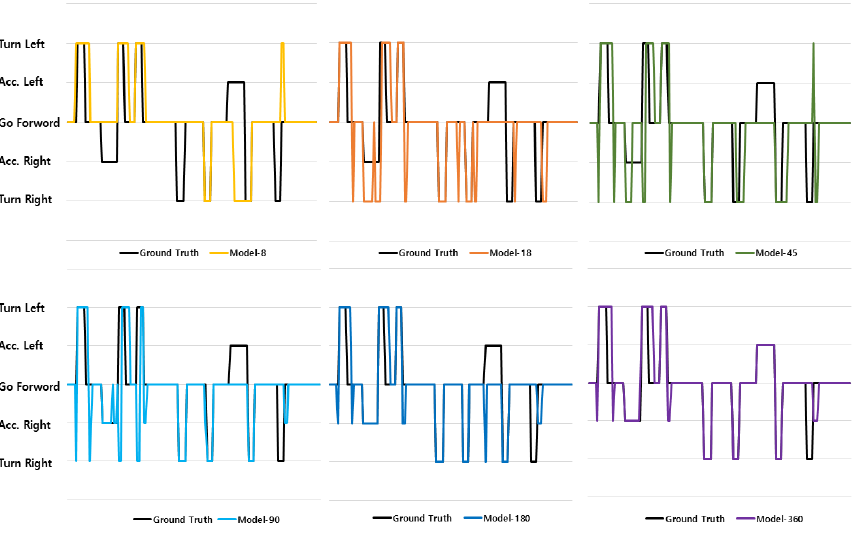
Figure 14. Driving Command Accuracy.